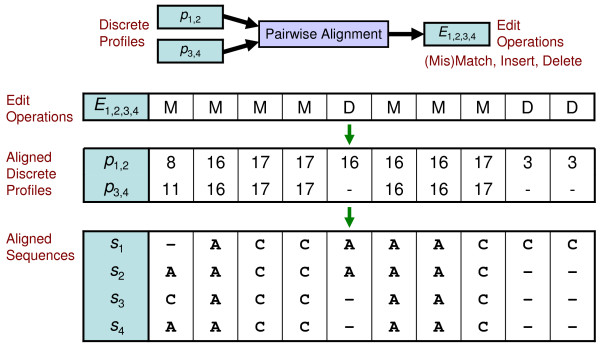
Example profile alignment. A pairwise alignment algorithm treats discrete profiles as sequences. The resulting edit operations E1,2,3,4 indicate the computed alignment between the discrete profiles p1,2 and p3,4, and the corresponding groups of sequences {s1, s2} and {s3, s4}.